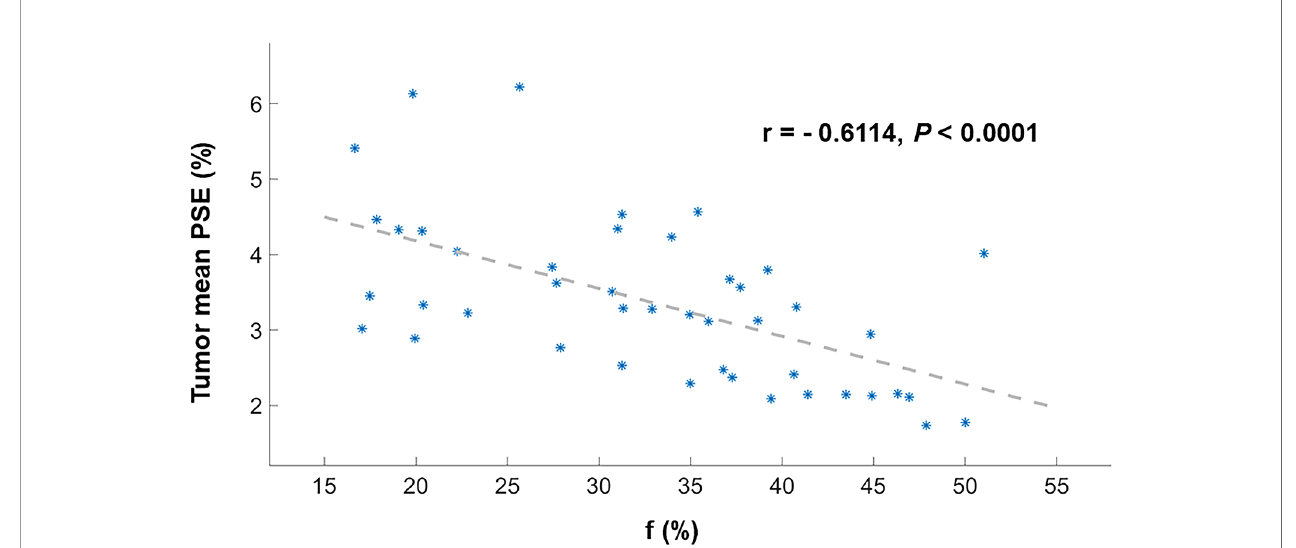
FIGURE 5 | Scatter plot depicting Spearman ’ s correlation between the tumor mean PSE and f. These dots (*) are the values for each patient.